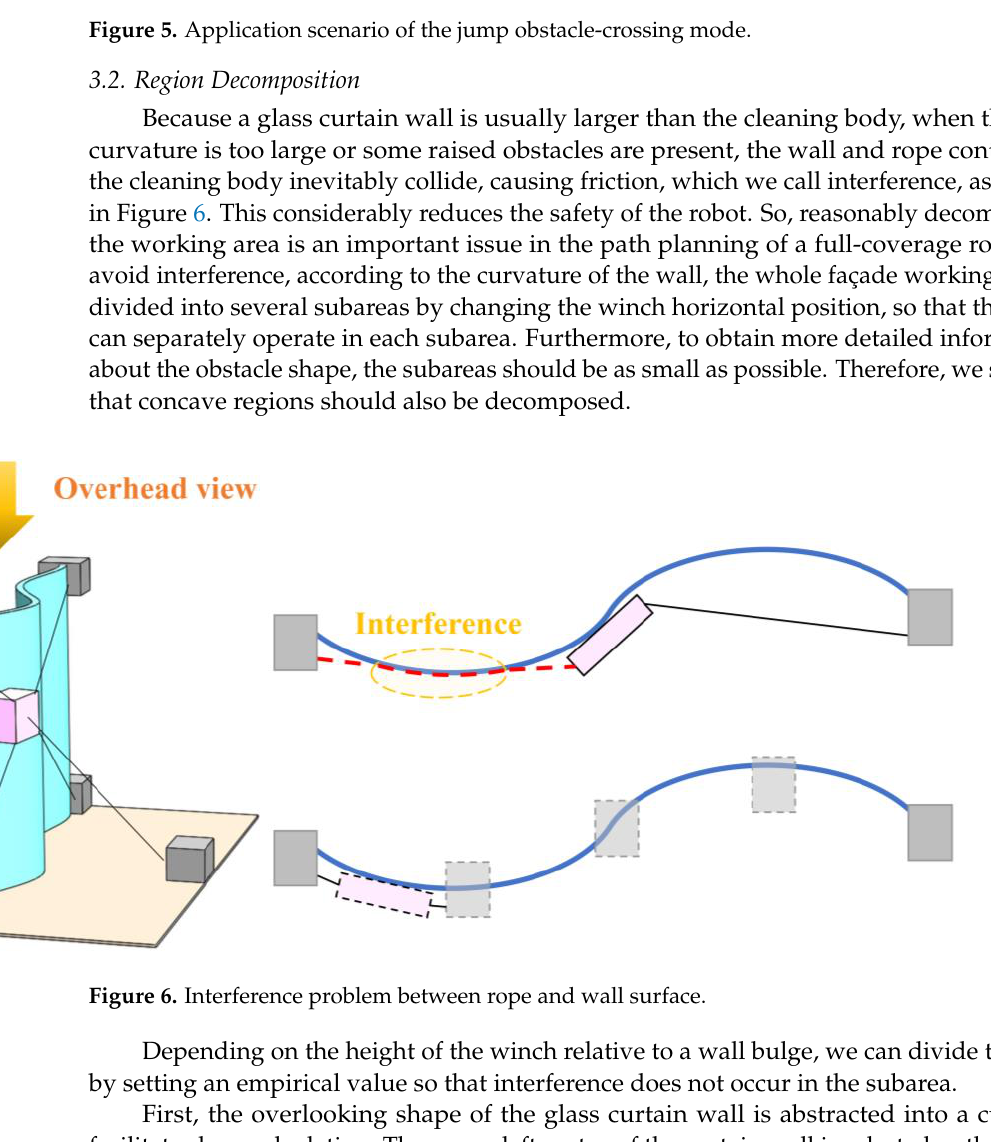
Figure 6. Interference problem between rope and wall surface.